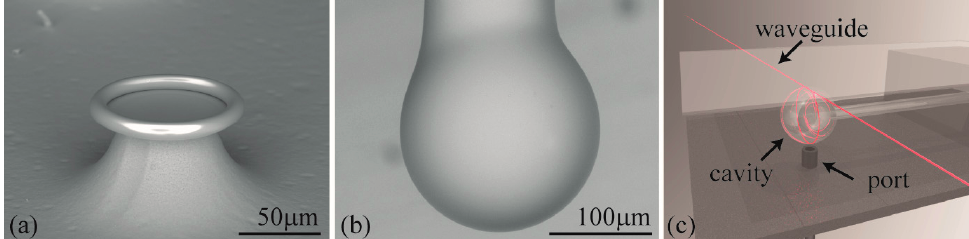
Figure 2. Scanning electron microscope image of a ( a ) toroid and a ( b ) microsphere resonator; ( c ) Rendering of the testing set-up with key components indicated. The liquid chamber consists of a steel holder and a glass cover slip. If a toroid is used in the experiments, then the injection port is located on the